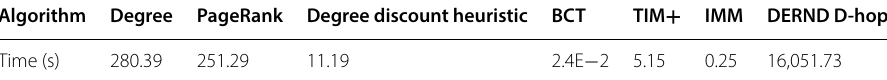
50 under the LT model =